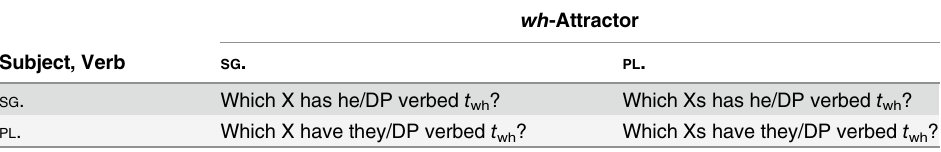
Table 1. Test item schema ( t indicates the gap